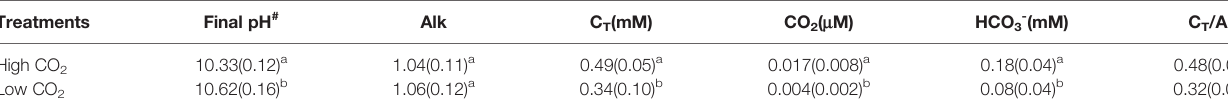
TABLE 3 | Final pH, alkalinity, and carbon concentrations at the end of pH-drift experiments. Treatments